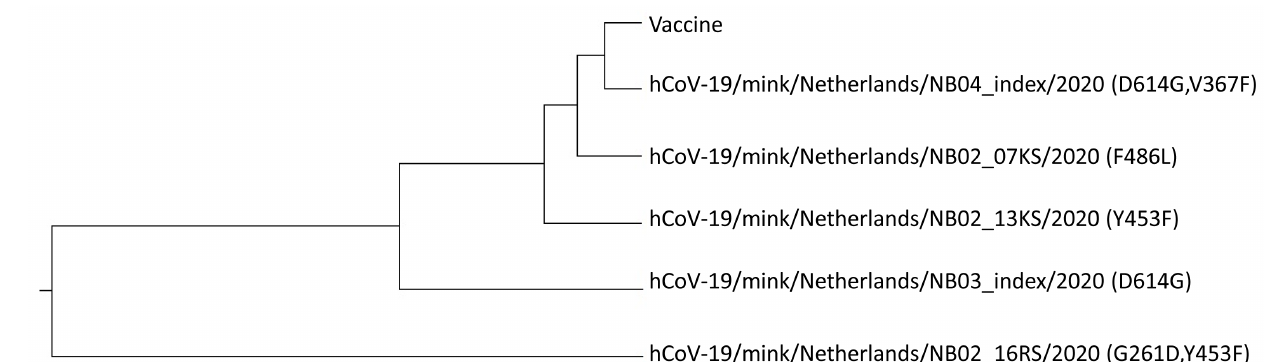
Figure 3. The ISM-based phylogenetic tree of the non-redundant SP1 proteins from SARS-CoV-2 isolated from minks (GISAID).